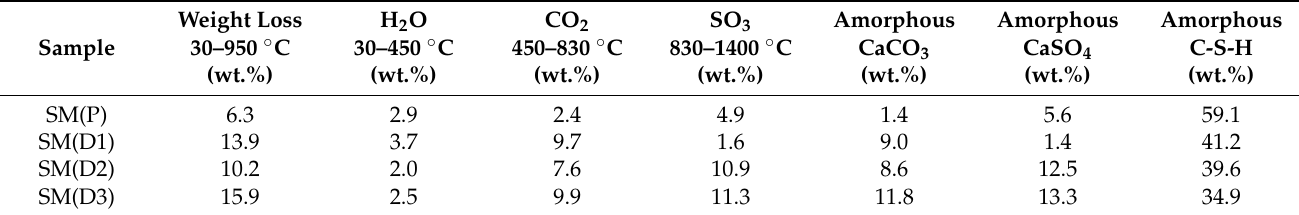
Table 3. Results from thermal analysis of the raw materials. Weight losses between 30 ◦ C and 450 ◦ C, 450 ◦ C and 830 ◦ C, and 830 ◦ C and 1400 ◦ C are assumed to be representative for the weight losses due to the release of H 2 O, CO 2 , and SO 3 with errors of ± 0.5 wt.% that result from overlap in the ranges 450 ◦ C to 500 ◦ C and 830 ◦ C to 900 ◦ C. Amorphous CaCO 3 , CaSO 4 , and C-S-H were calculated from the results of TG and XRD.